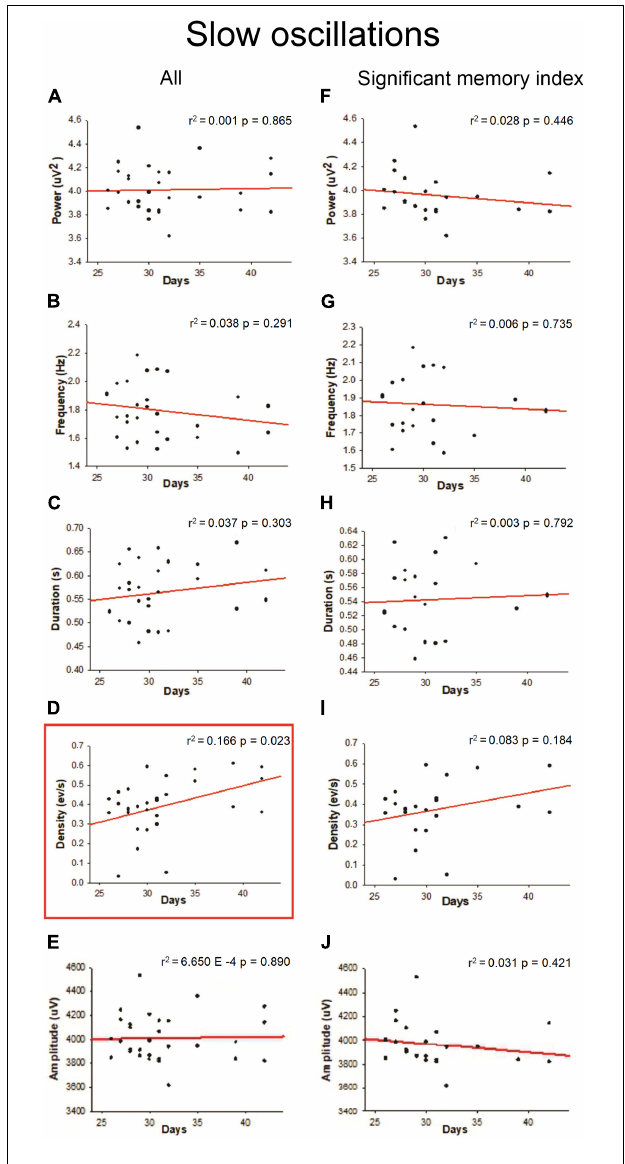
FIGURE 4 | Linear regression between SO oscillation features with respect to developmental ages. For each postnatal day, the power (A,F) , frequency (B,G) , duration (C,H) , density (D,I) , and amplitude (E,J) were computed. The correlation analysis considered "All" animals (column on the left) or those with a "significant memory index" (column on the right). The r 2 and p -value are indicated on each regression. Significant regression ( p < 0.05) is enclosed in a